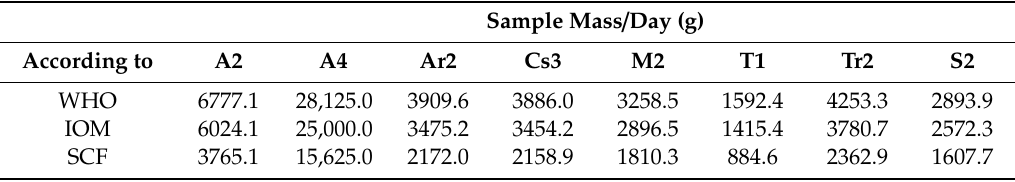
Table 7. Sample mass that can be consumed by day for